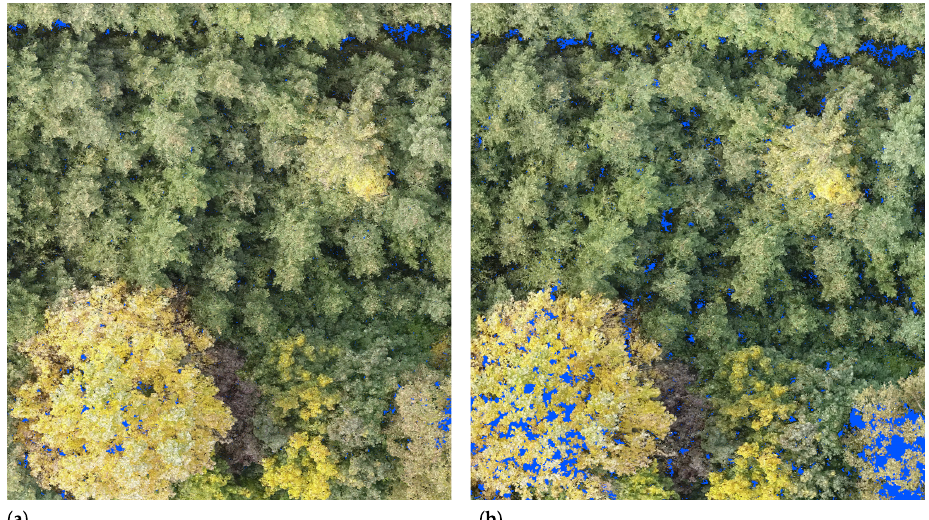
Figure 5. Illustration of a section of the dense point cloud based on different tie point densities. ( a ) Dense reconstruction with a side overlap of 90% and 753,239 tie points in the sparse point cloud and 67,582,712 points in the total dense point cloud. ( b ) Dense reconstruction with a side overlap of 55% and 185,349 tie points in the sparse point cloud and 35,413,159 points in the total dense point cloud. Clearly visible are the missing points indicated by the blue background in the deciduous trees of the lower left and right corner of ( b